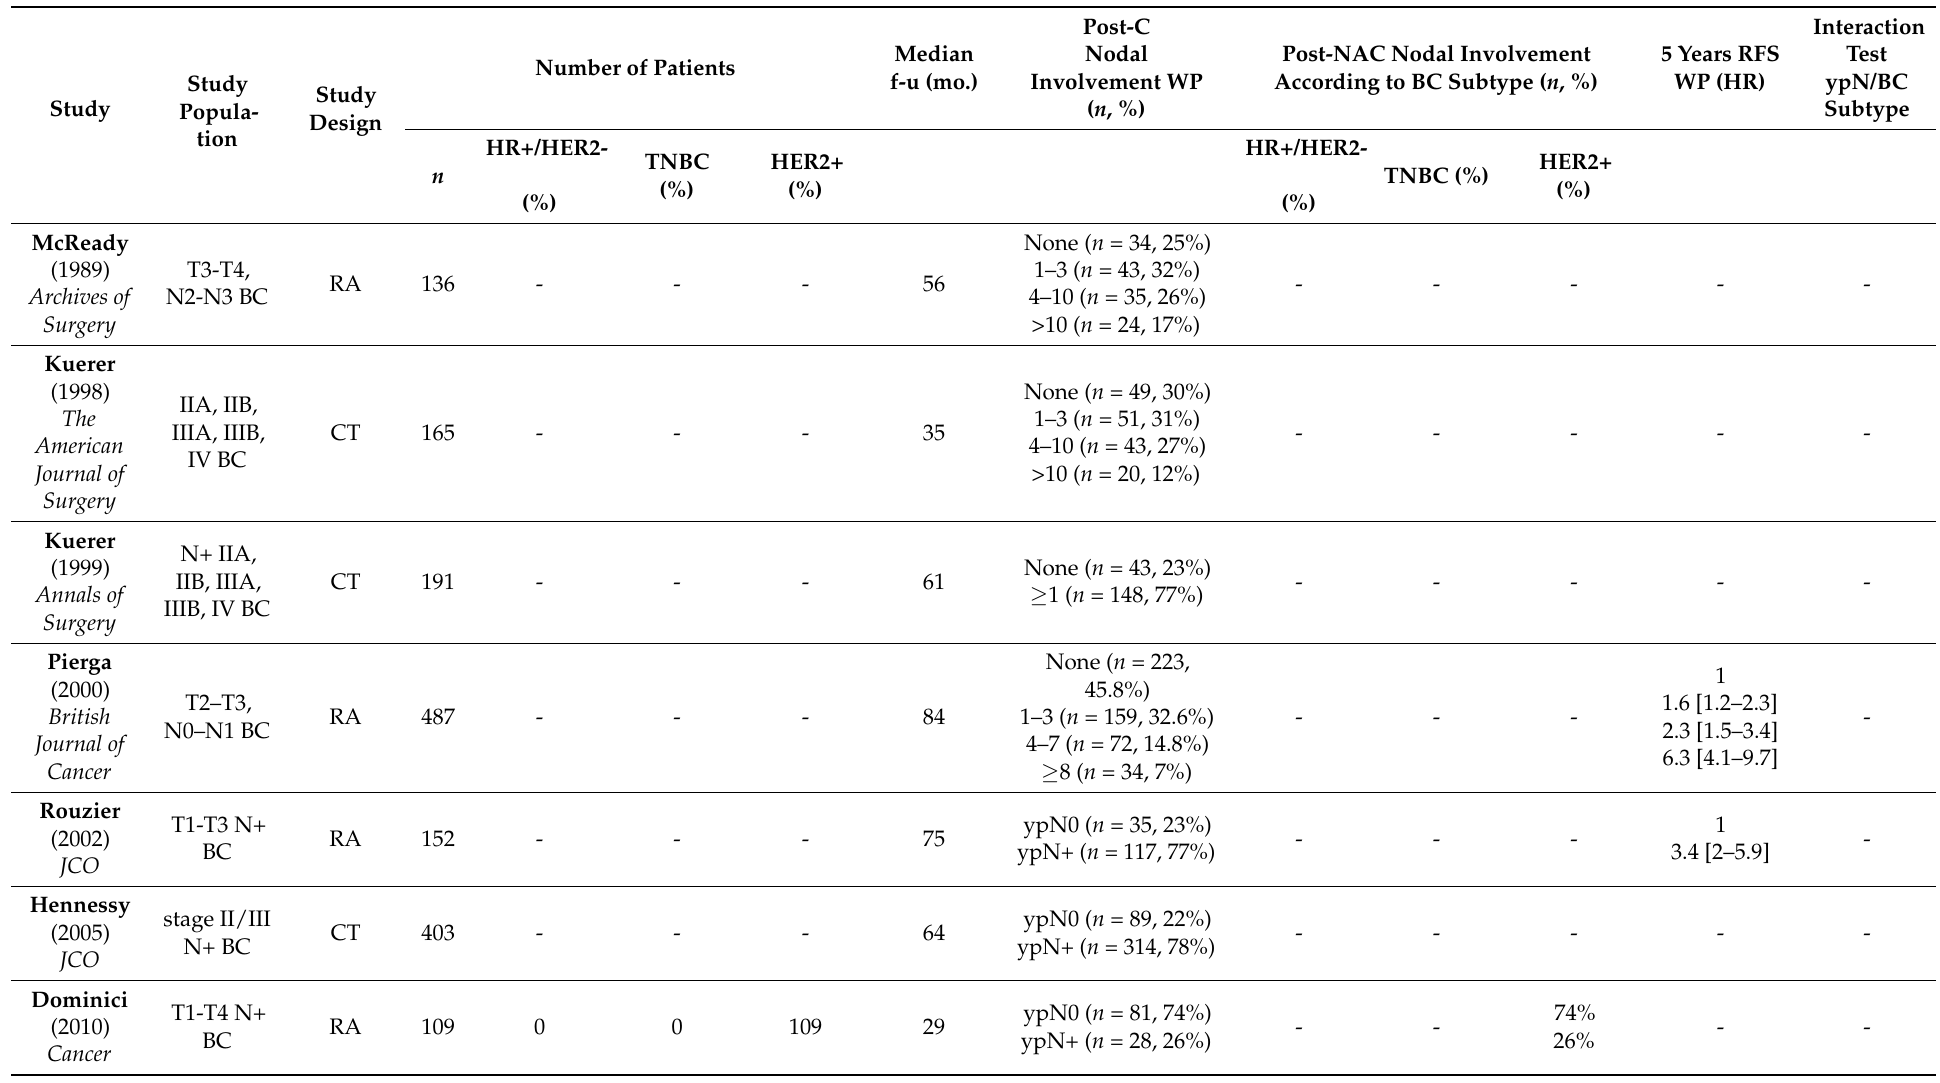
Table 4. Summary of previous studies comparing prognosis according to nodal involvement after neoadjuvant chemotherapy (NAC) according to breast cancer